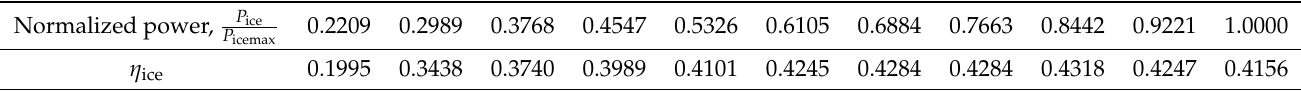
Table A1. Maximum ICE efficiency against normalized power